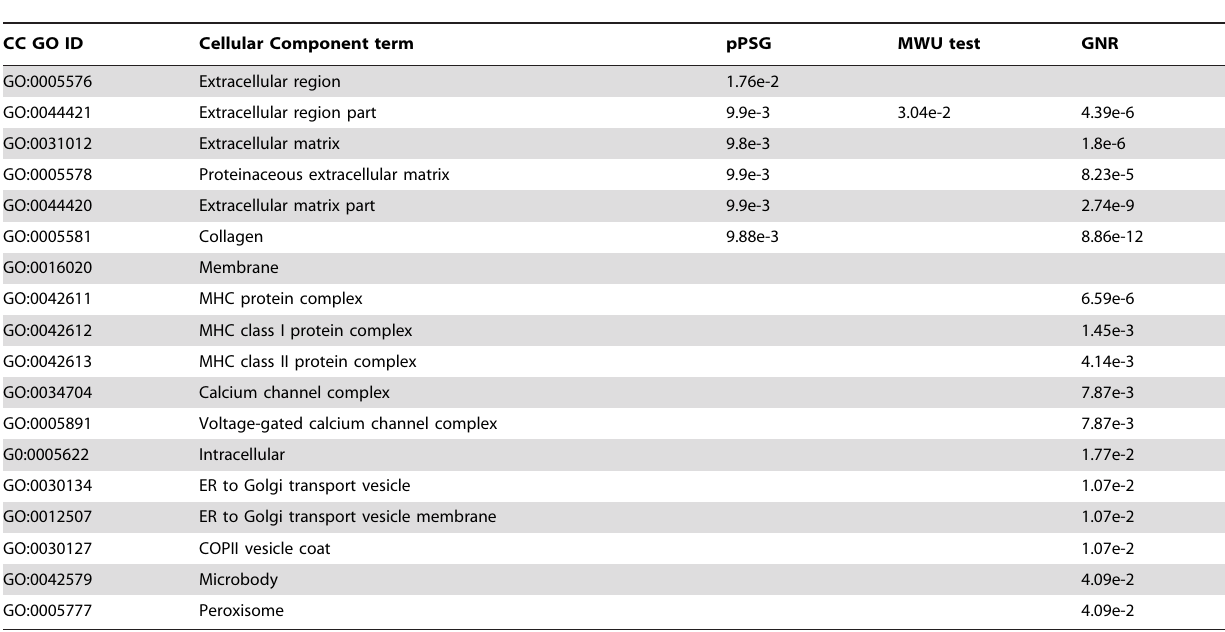
Table 3. Cellular Component GO terms enriched with either pPSG, with genes displaying small P -values as given by the MWU test, or with